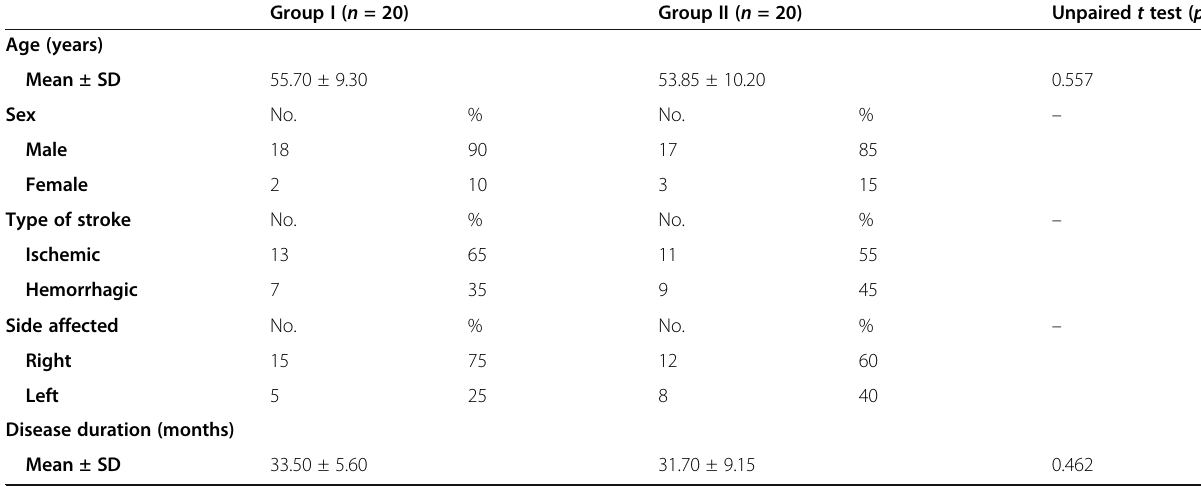
Table 1 Demographic and clinical data of the studied groups showing that the two groups are matched regarding patient ’ s age and disease duration